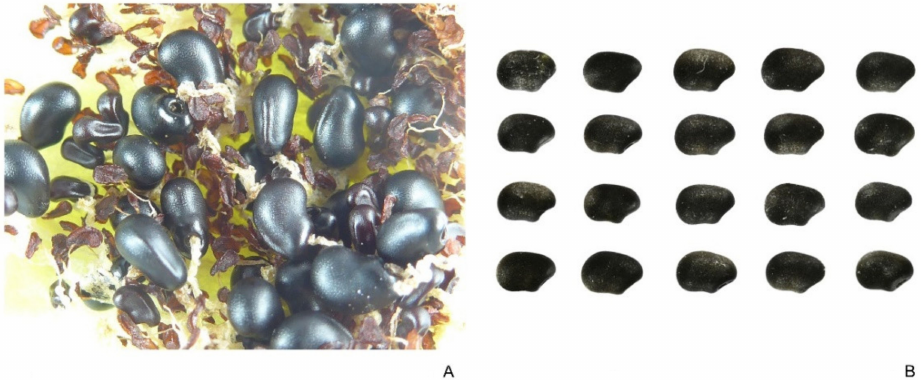
Figure 7. Ferocactus herrerae . ( A ) Seeds in a fruit. ( B ) Seeds. Bar equals 1 cm.